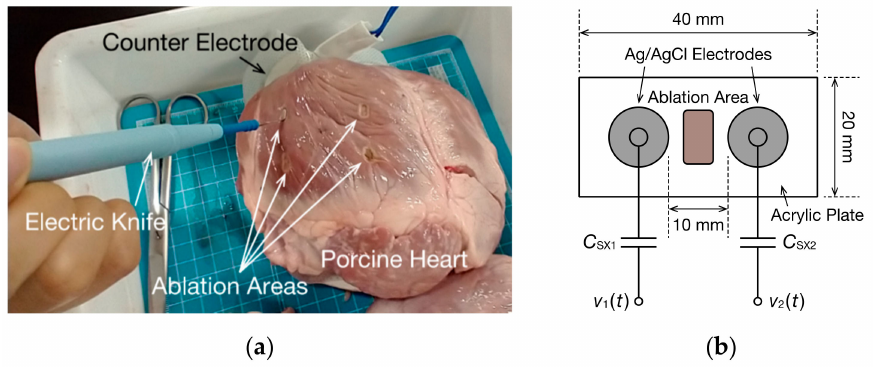
Figure 2. Impedance measurement of porcine myocardium: ( a ) photograph of the porcine left ventricle coagulated using electrocautery; ( b ) measurement electrode